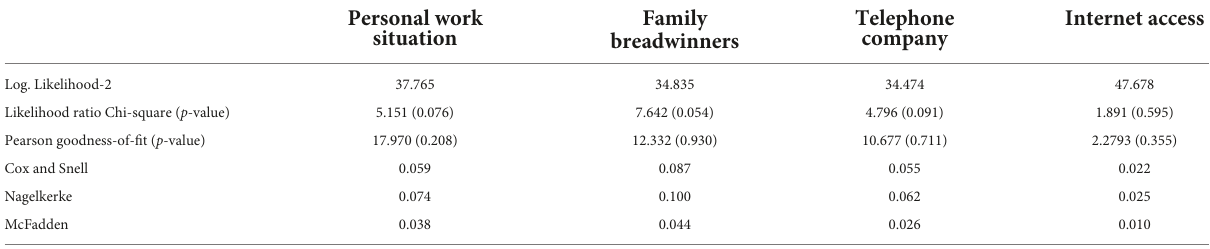
TABLE 8 Model fitting using likelihood ratio, goodness-of-fit and Pseudo R2